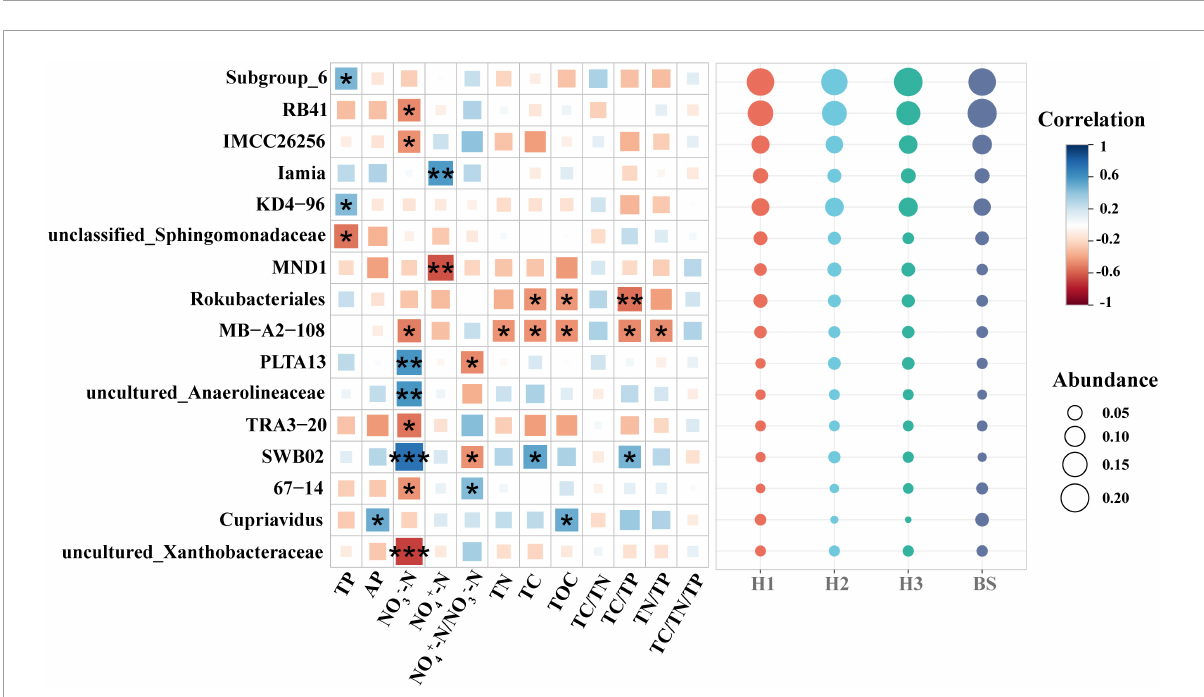
FIGURE5 The correlation matrix between soil nutrient properties and abundant bacteria genera (the relative abundance over 1%) in rhizosphere and bulk soils of poplar. ***, ** and * show significant correlation at the 0.001, 0.01 and 0.05 level, respectively.